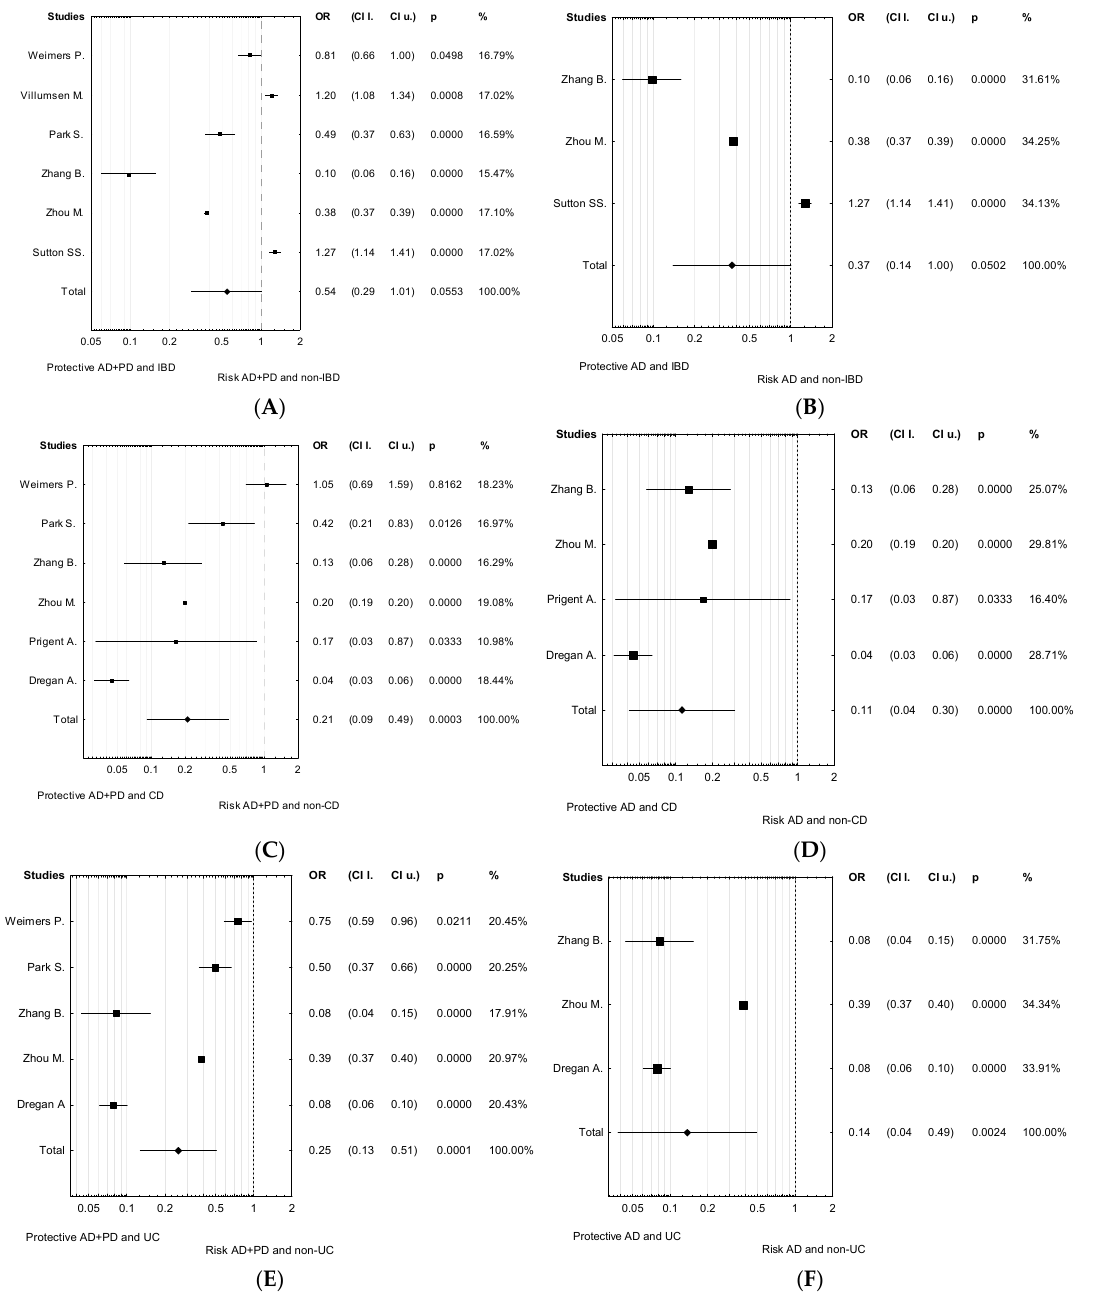
Figure 2. Meta-analysis result: forest plot diagrams depicting the association between neurodegenerative disease, including AD and PD and IBD ( A ); AD and IBD ( B ); neurodegenerative disease, including AD and PD and CD ( C ); AD and CD ( D ); neurodegenerative disease, including AD and PD and UC ( E ); AD and UC ( F ).